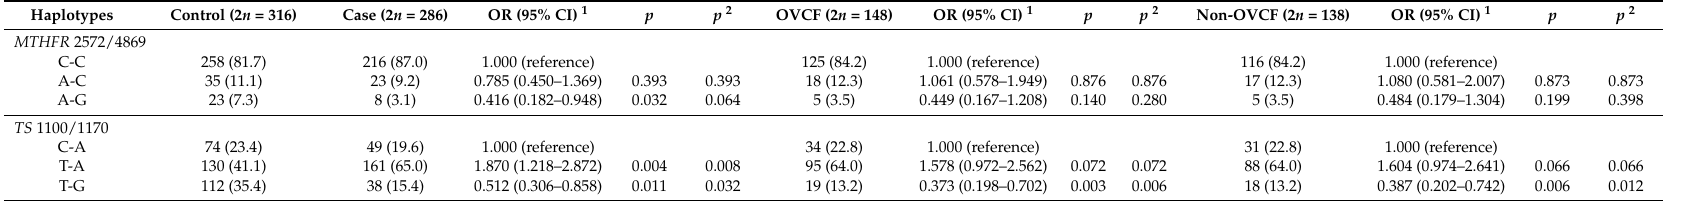
Table 4. Comparison of genotype frequencies of MTHFR and TS gene allele combinations between the osteoporosis and control subjects.